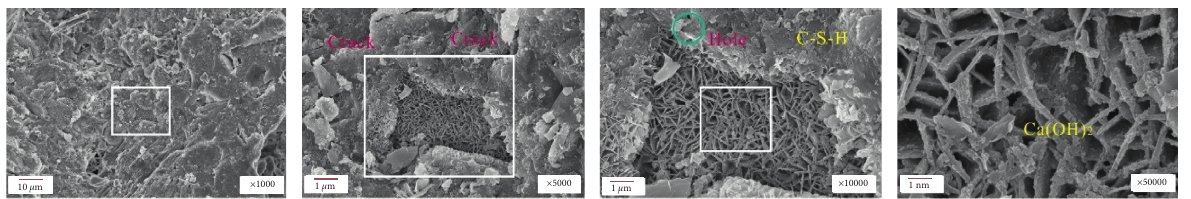
Figure 24: C-8 concrete microstructure after 400 freeze-thaw